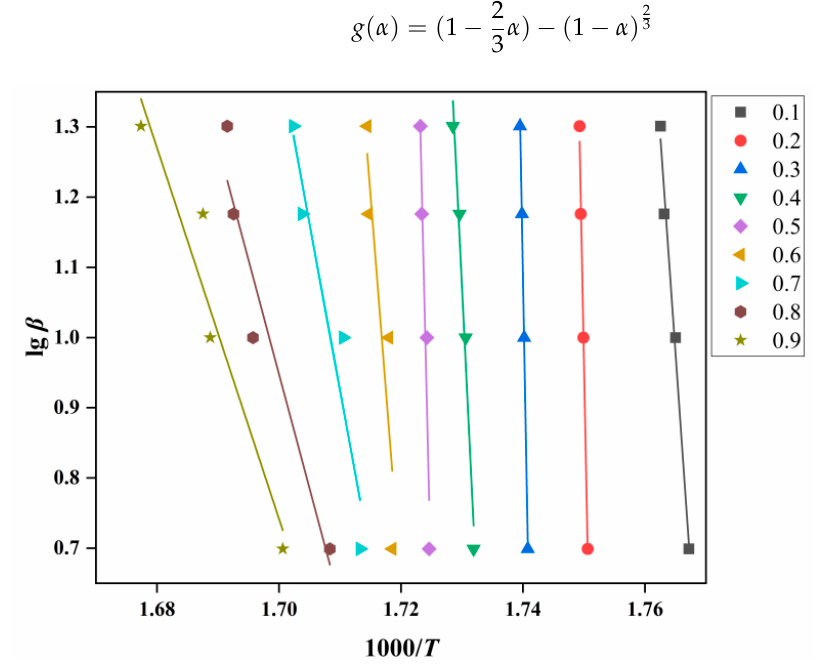
Figure 8. E O analysis diagram of ATRZ created by the Ozawa method.